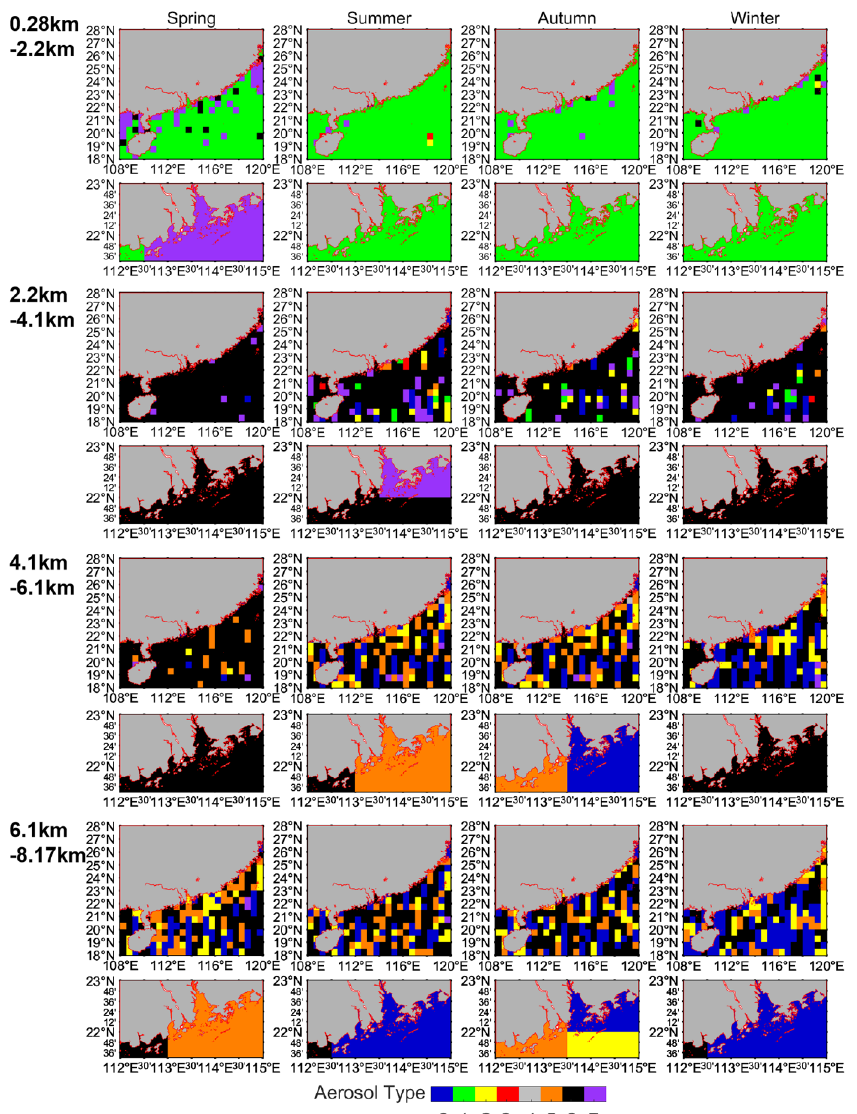
Figure 6. Dominant aerosol types over the NSCS and the coastal waters of the GBA at different heights (the first row of the same layer is for the NSCS, and the second row is for the coastal waters of the GBA; 0 = Not-Determined; 1 = CM; 2 = DU; 3 = PC; 4 = CC; 5 = PD; 6 = ES; 7 = DM).